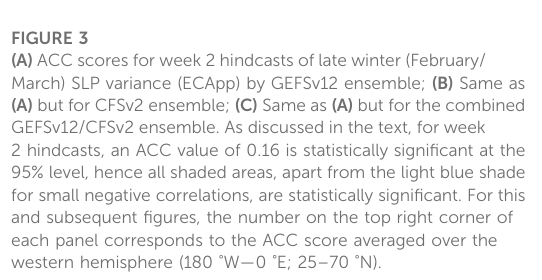
FIGURE 3 (A) ACC scores for week 2 hindcasts of late winter (February/ March) SLP variance (ECApp) by GEFSv12 ensemble; (B) Same as (A) but for CFSv2 ensemble; (C) Same as (A) but for the combined GEFSv12/CFSv2 ensemble. As discussed in the text, for week 2 hindcasts, an ACC value of 0.16 is statistically signi fi cant at the 95% level, hence all shaded areas, apart from the light blue shade for small negative correlations, are statistically signi fi cant. For this and subsequent fi gures, the number on the top right corner of each panel corresponds to the ACC score averaged over the western hemisphere (180 ° W — 0 ° E; 25 – 70 °